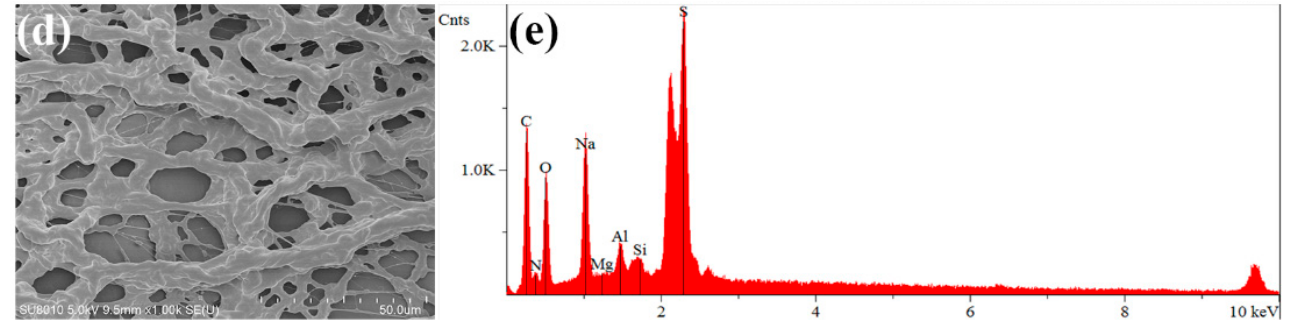
Figure 7. SEM images of ( a , b ) ASD and ( c , d ) ASD/1.0 wt% O-MMt and ( e ) EDS analysis of ASD/1.0 wt% O-MMt.